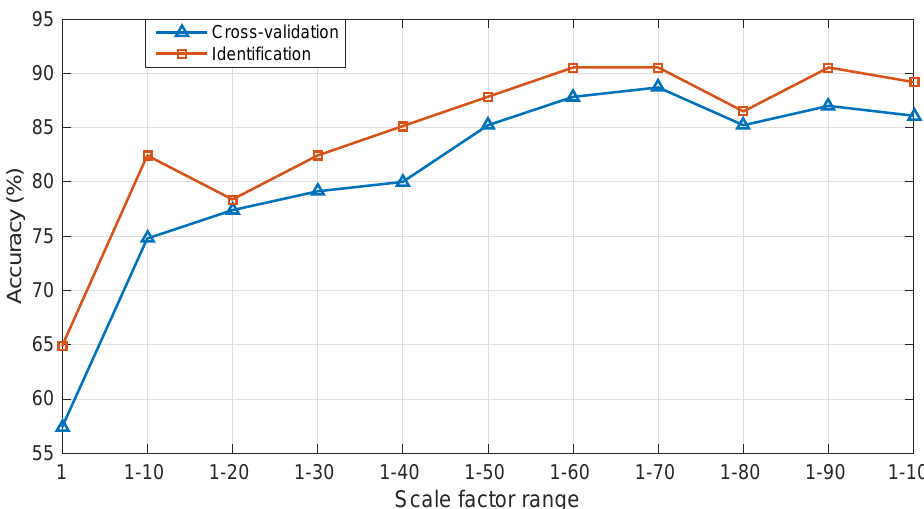
Figure 8. Cross-validation accuracy and identification accuracy using IPSO-MSVM under different scale factor ranges.